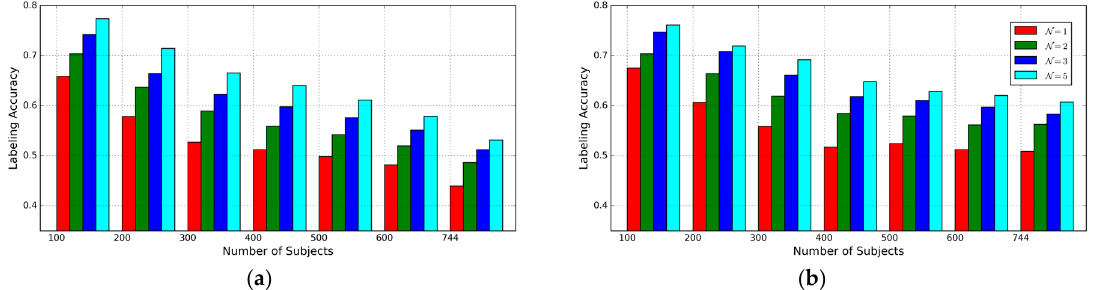
Figure 8. The impact of the number of subjects on gait labeling accuracy given different (cid:2280) values: ( a ) TCNN based Method 3; ( b ) the proposed approach.